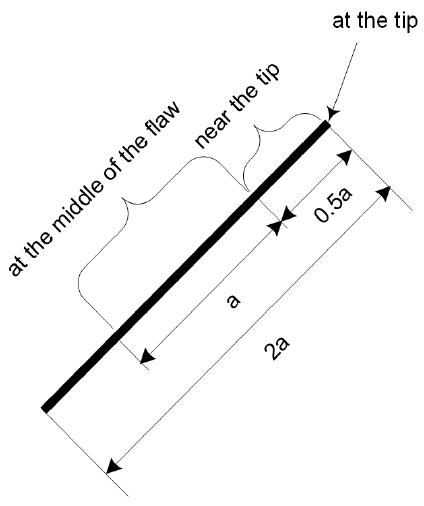
Figure 5. Wing crack initiation position.